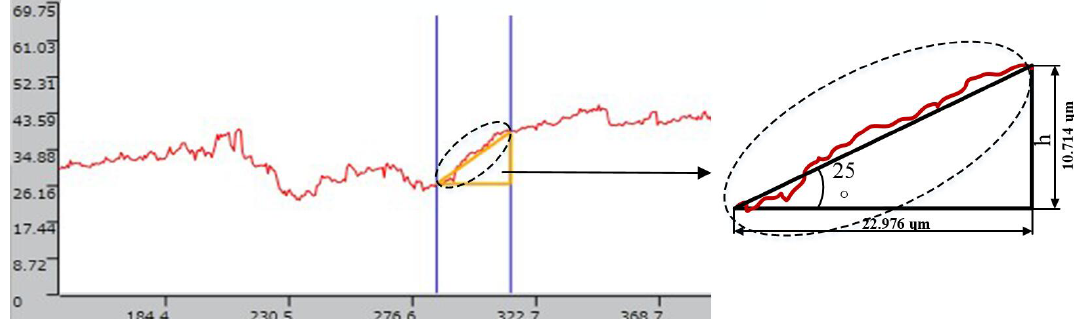
Figure 8. Section profile of the pit on machined